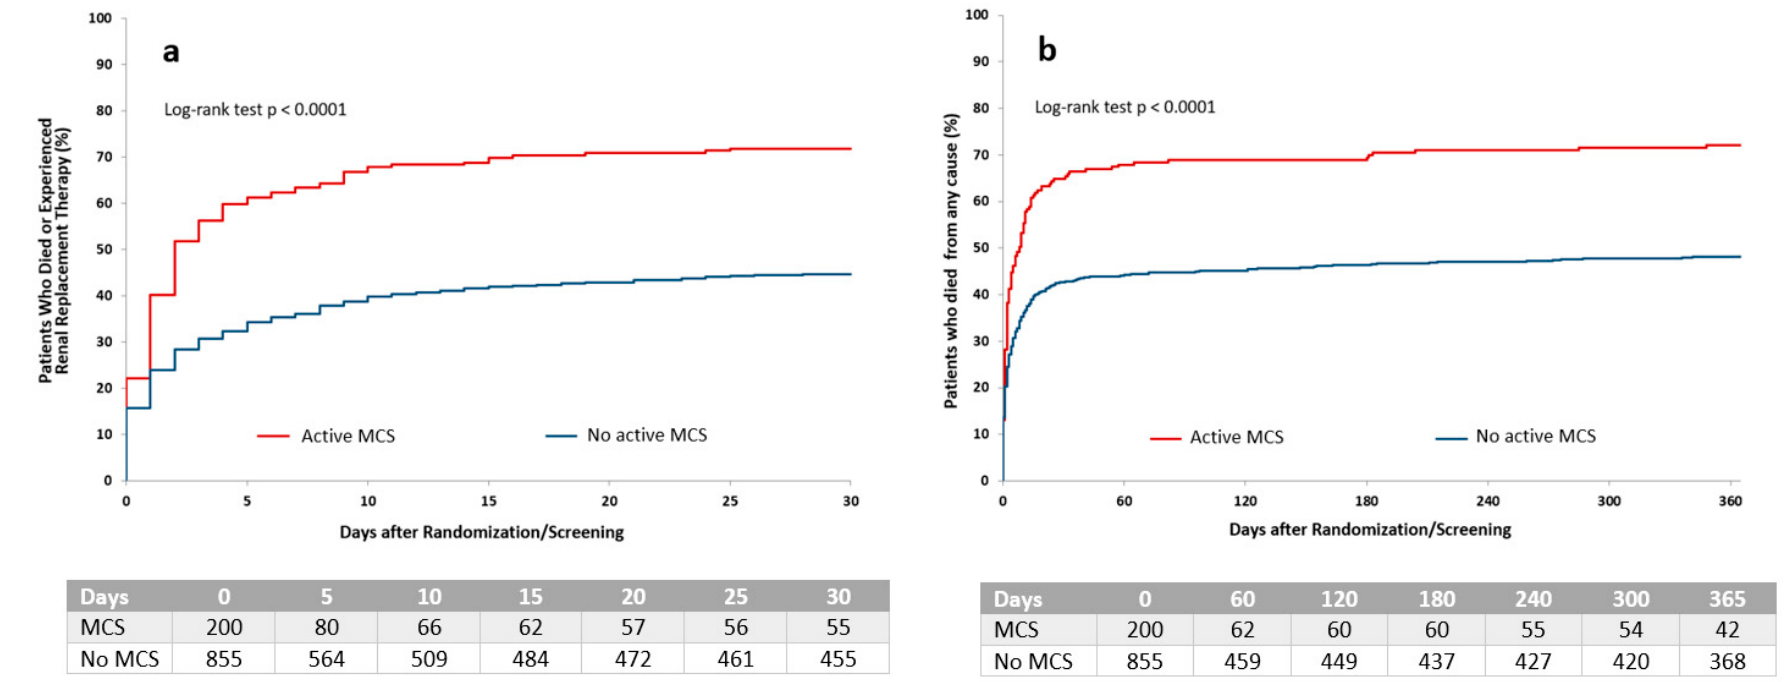
Figure 2. Kaplan–Meier curves of the time to the occurrence of the primary endpoint of all-cause death or renal replacement therapy at 30 days ( a ), and 1-year mortality ( b ). MCS = mechanical circulatory support.